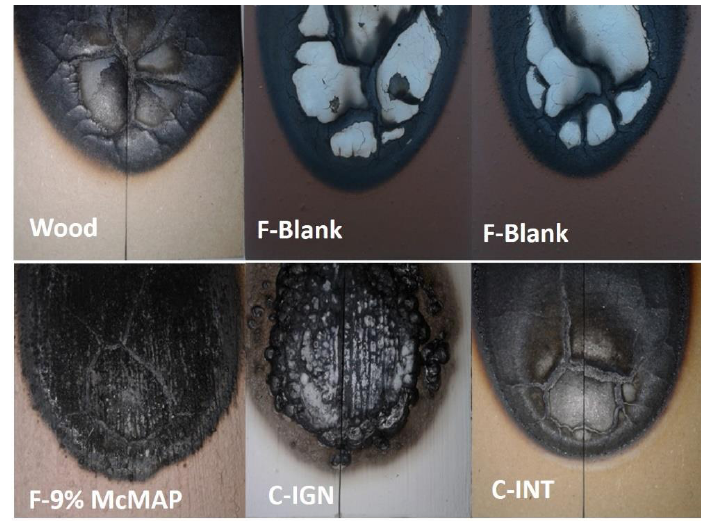
Figure 6. Flame resistance of the formulated coatings. Figure 7 illustrates the temperature versus time curve of the flame resistance test.